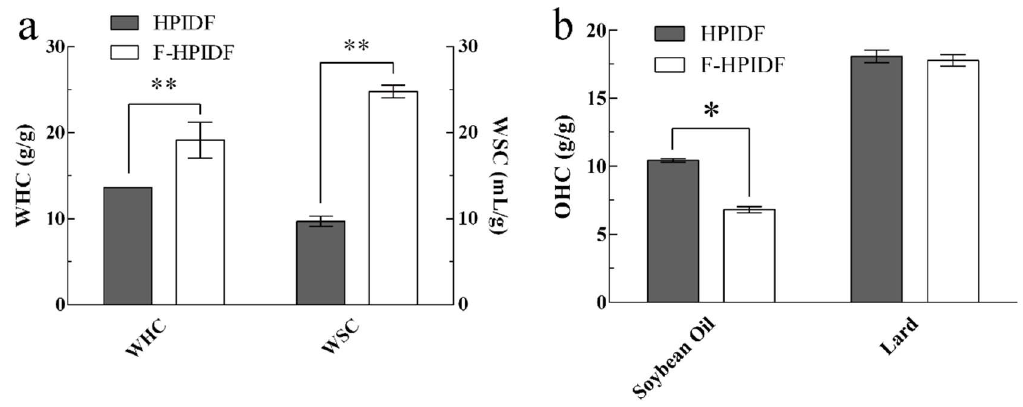
Figure 6. WHC, WSC and OHC of HPIDF/F-HPIDF. ( a : WHC & WSC; b : OHC; *: p < 0.05; **: p < 0.01).